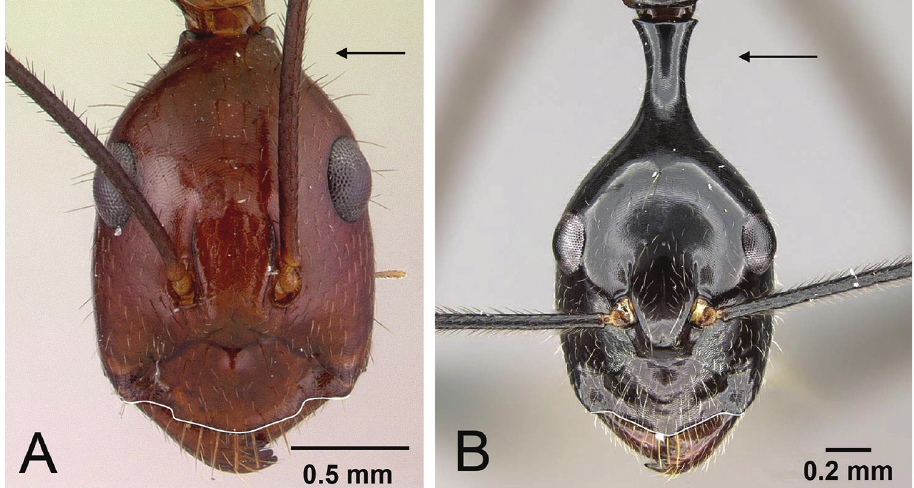
Figure 4. Illustration of the neck (posterior region of the head) and the anterior clypeal margin of A Camponotus imitator (CASENT0452849), and B Camponotus karaha (CASENT0152090). Arrows indicate the posterior portion of the head capsule which in karaha is drawn out into a strongly constricted neck, behind which the head capsule flares out, forming a pronounced collar.